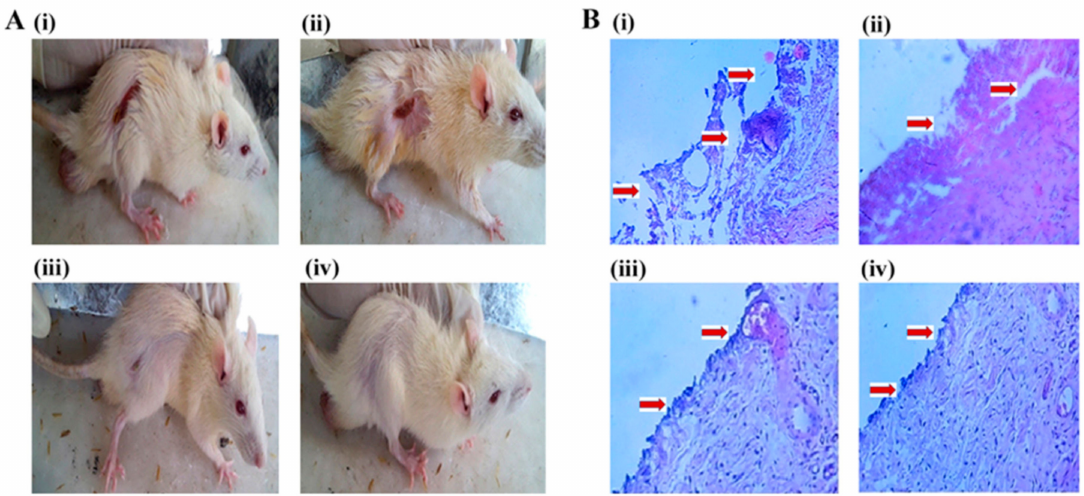
Figure 6. ( A ) Comparative burn wound healing images of rats after 21 days. ( B ) Histopathology of re-epithelialized rat skin after 21 days treatment, at 10 × magnification. The treatment group includes (i) untreated (diseased control); (ii) silver sulfadiazine marketed cream; (iii) Silver sulfadiazine-loaded solid lipid nanoparticles-containing chitosan gel; (iv) Silver sulfadiazine-loaded solid lipid nanoparticles and DNase-I-containing chitosan gel. Reproduced from Patel et al.